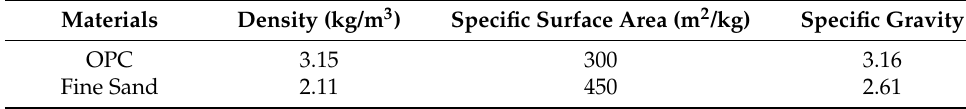
Table 1. The physical properties of OPC and fine sand.